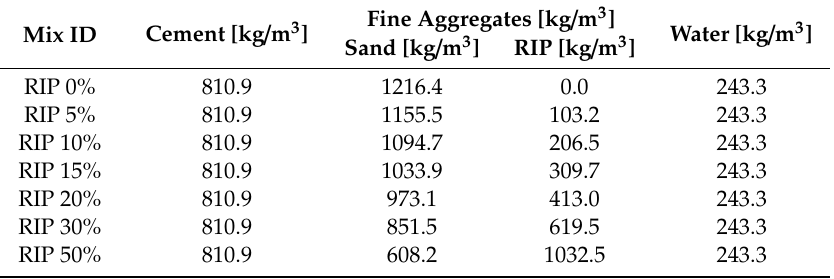
Table 3. Mixture proportion of mortar